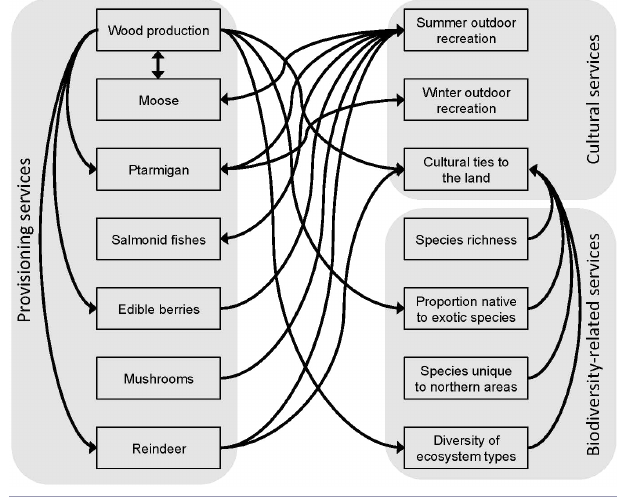
Fig. 4 . Potential interactions among the ecosystem services studied. Arrows indicate that change in one ecosystem service is expected to have repercussions on or lead to changes in another service. In cases where the interactions go both ways, the arrows are double-headed. Only the interlinkages judged to be most relevant are depicted by